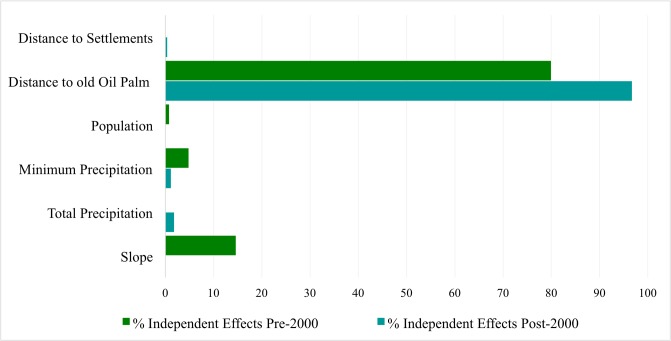
Independent contributions of significant variables for pre-2000 and post-2000 using hierarchical partitioning.